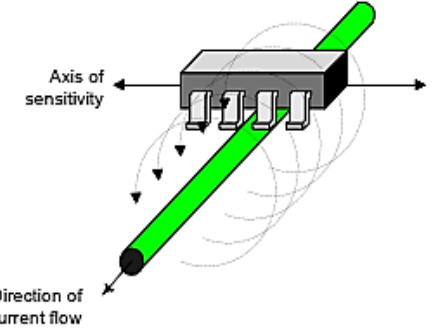
FIGURE 3. Sensing magnetic field from a current-carrying wire. [12] Fig. 4 shows the sensor response as measured in the laboratory; the earth’s magnetic field was not compensated during